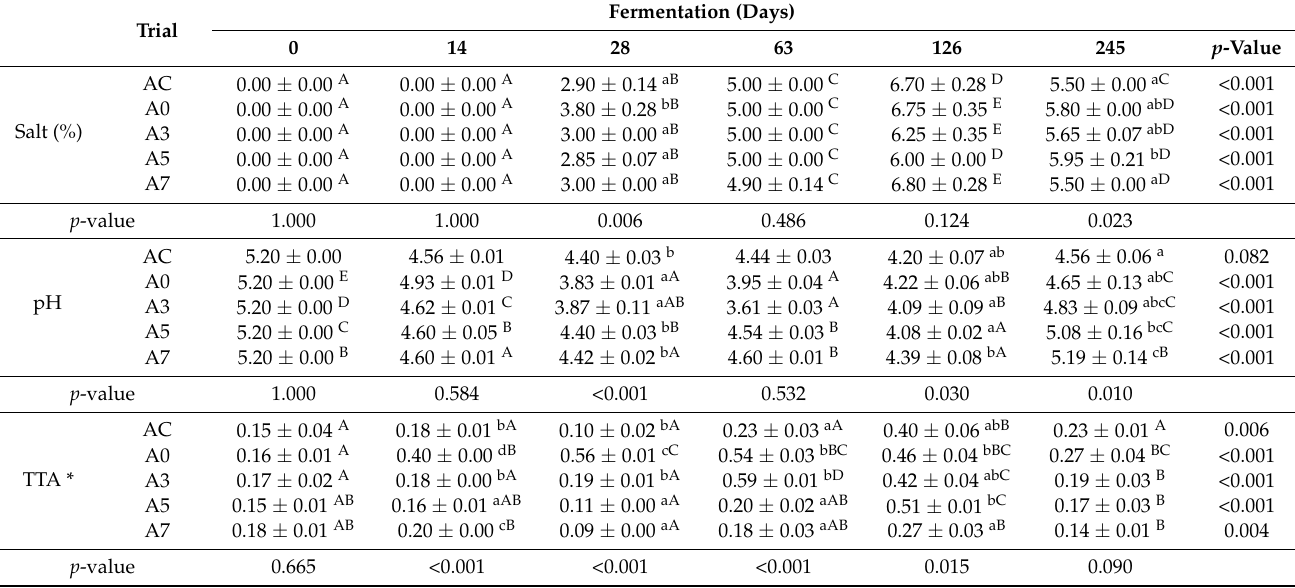
Table 1. Evolution in physicochemical features (salt content, pH, and total titratable acidity) of brine at selected times of fermentation under plan